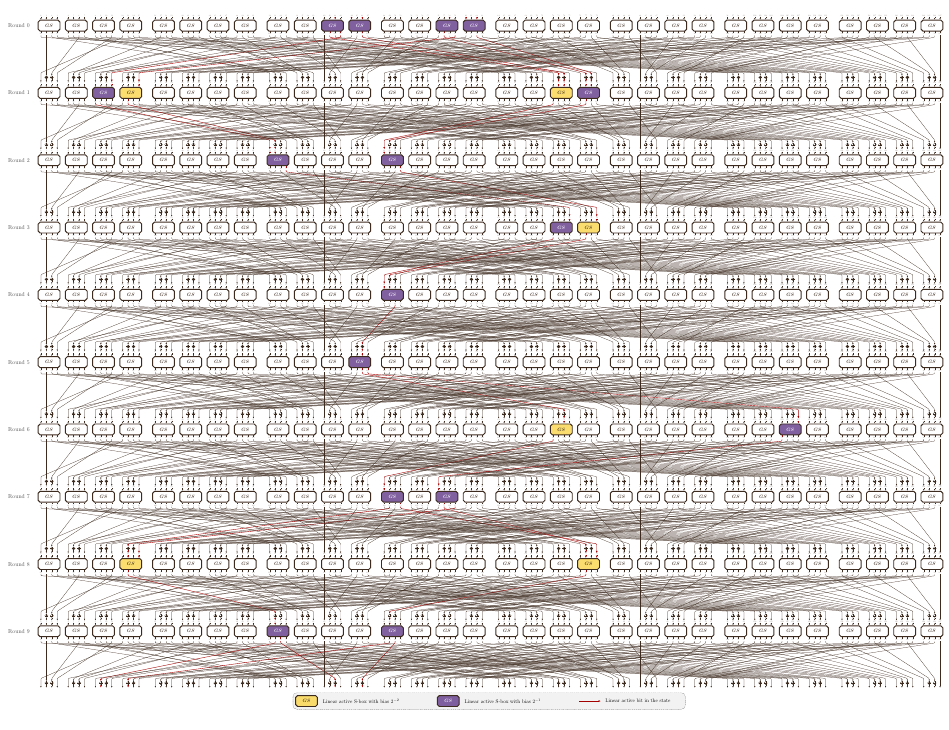
Figure 5: 10-round trail with c = 2 − 28 in the approximation concerning SUNDAE-GIFT .